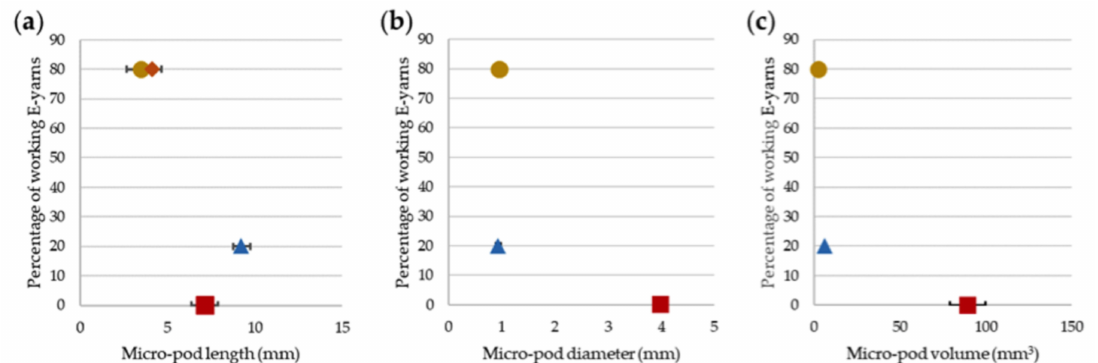
Figure 15. Percentage E-yarns functioning after 25 machine washing and line drying cycles as a function of: ( a ) Micro-pod length. ( b ) Micro-pod diameter. ( c ) Micro-pod volume. Illuminated E-yarns containing LEDs ( ), LEDs mounted on polyimide strip circuits embedded within the E-yarns ( ), Temperature sensing E-yarn ( ; obscured in parts b and c), Acoustic sensing E-yarns ( ).